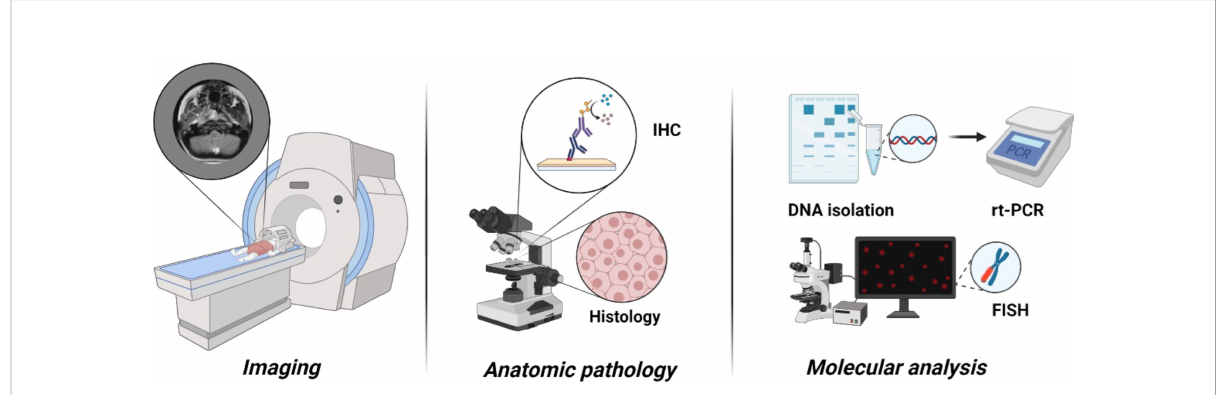
FIGURE 2 The role of molecular analysis for differential diagnosis and classi fi cation of RMS. Molecular analysis helps to identify the subtypes and classify RMS.